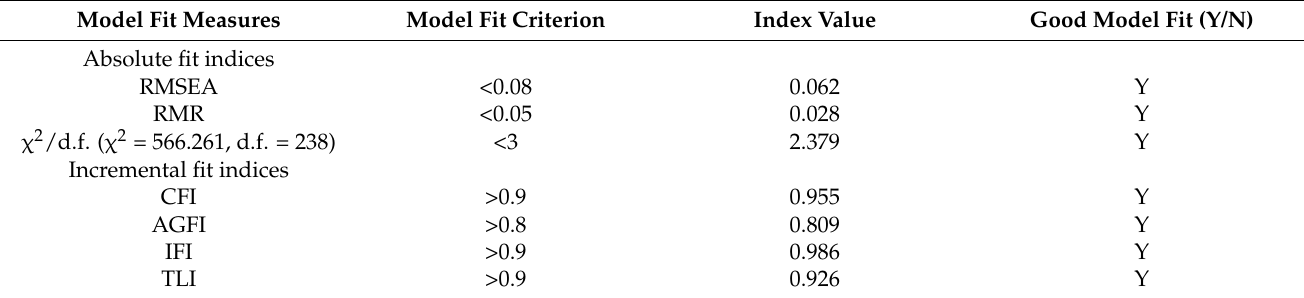
Table 2. Fit indices for the measurement